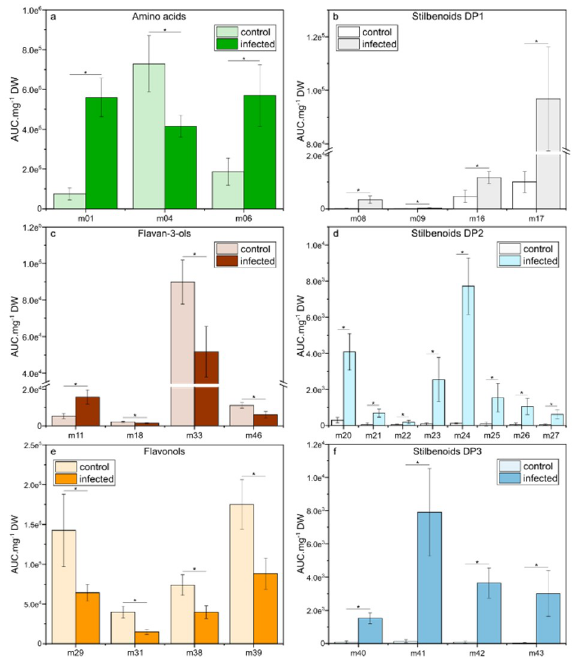
Figure 6. Relative concentrations of the selected metabolites in leaves of Vitis vinifera L. cv. Malbec upon downy mildew infection at 15 dpi. Data are mean values ± standard deviation (control: n = 6; infected: n = 6). Asterisk: significance difference from control ( p < 0.05).